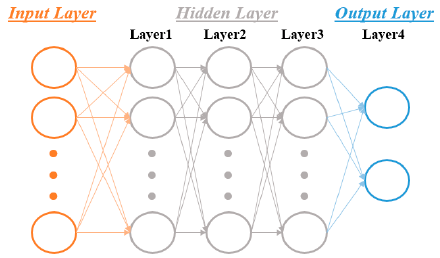
Figure 4. Diagram of the artificial neural networks.